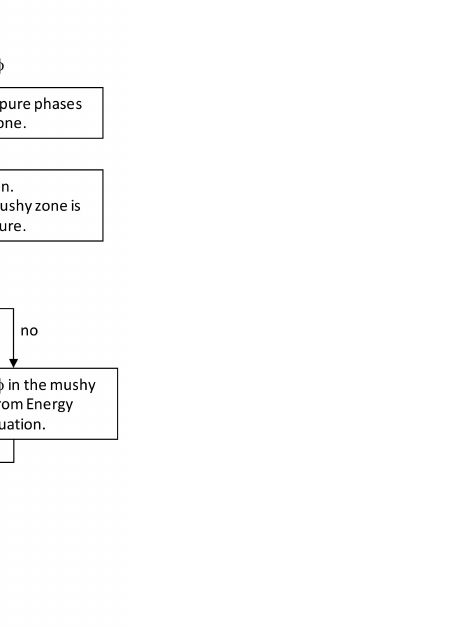
Figure 1. Flowchart of algorithm for binary alloy solidification proposed by Felicelli et al.